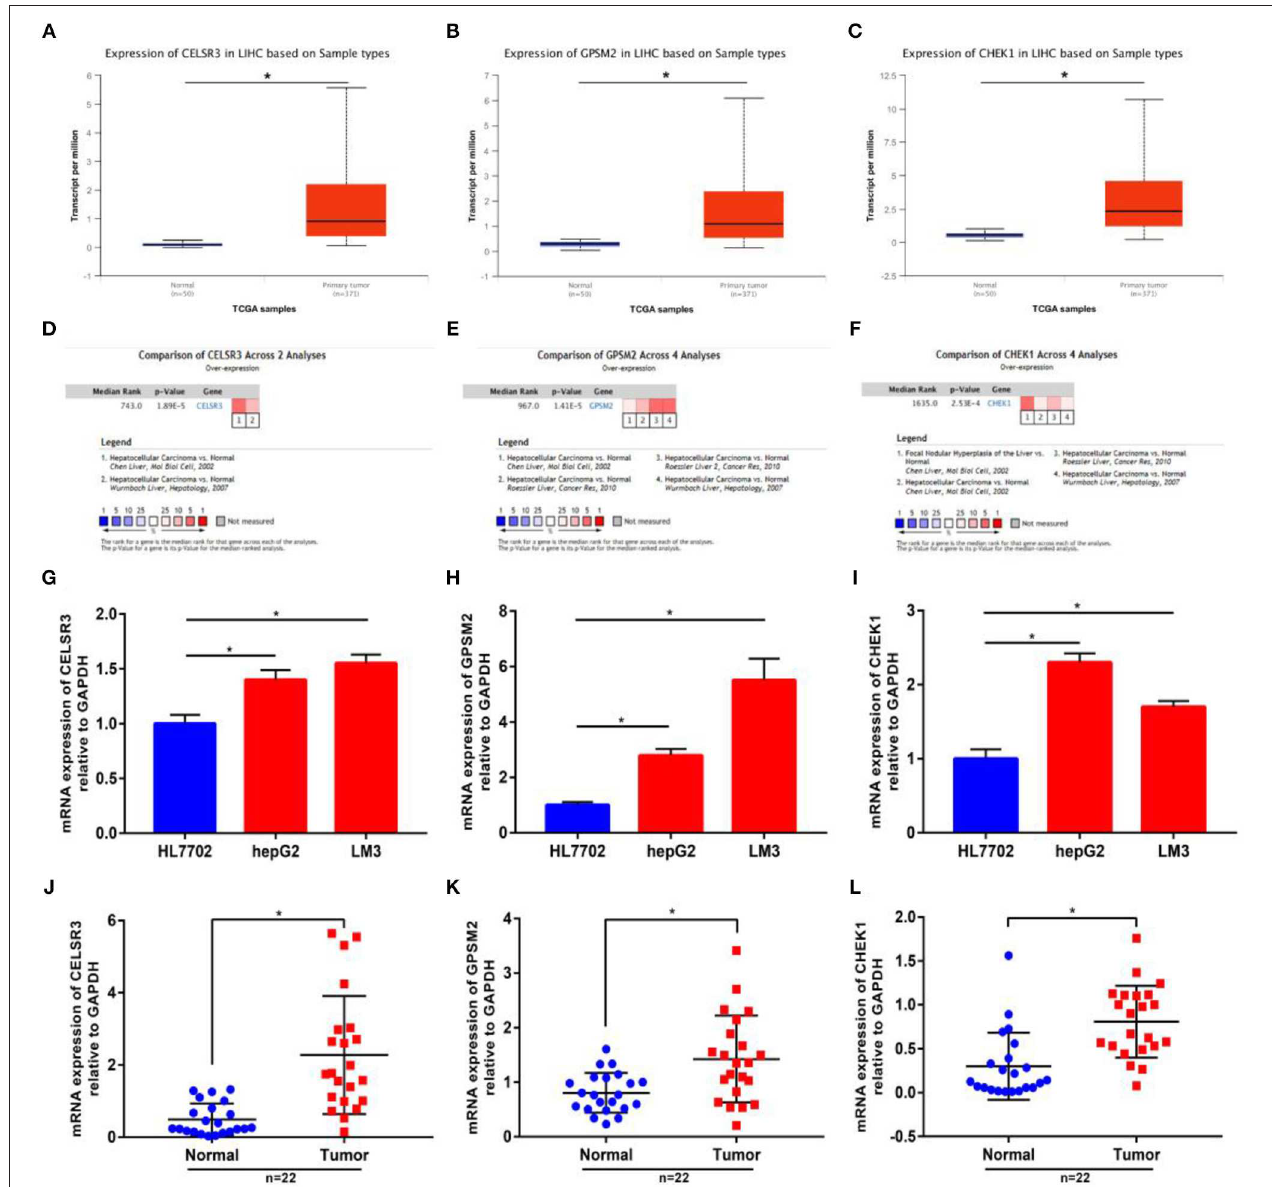
FIGURE 2 | The mRNA expression levels of CELSR3, GPSM2, and CHEK1 in hepatocellular carcinoma. mRNA expression of CELSR3 (A) , GPSM2 (B) , and CHEK1 (C) were significantly increased in tumor tissues compared to normal controls determined by UALCAN database; mRNA expression of CELSR3 (D) , GPSM2 (E) , and CHEK1 (F) were significantly increased in tumor tissues compared to normal controls determined by Oncomine database. CELSR3 (G) , GPSM2 (H) , and CHEK1 (I) were markedly upregulated in hepG2 and LM3 when compared with HL7702; mRNA expression of CELSR3 (J) , GPSM2 (K) , and CHEK1 (L) were obviously higher in tumor tissues than that in adjacent normal tissues; normalization was done relative to GAPDH. * P <